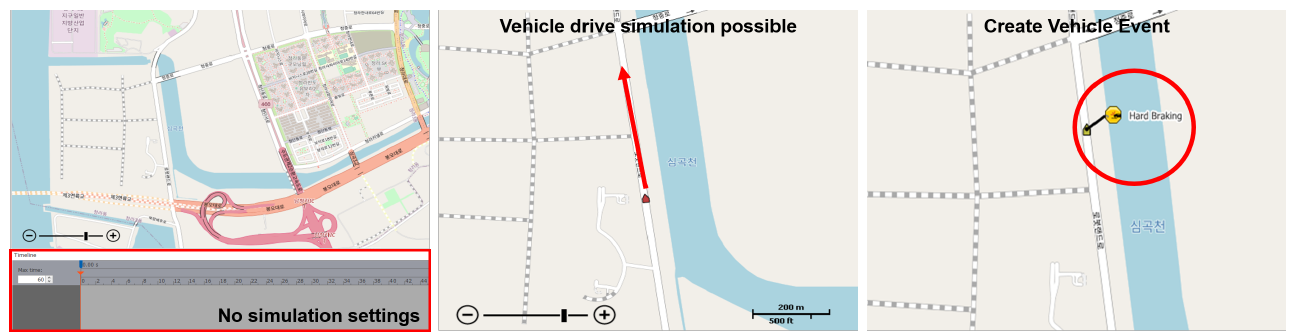
Figure 10. This figure shows driving by sending V2X data to a simulation node linked to the virtual machine and generating a vehicle event (hard braking) without using the scenario editor. The simulation node generates a message according to the standard specifications for the data received from the virtual machine and sends it to the simulation network. The user can create scenarios for specific situations or events according to the test cases.